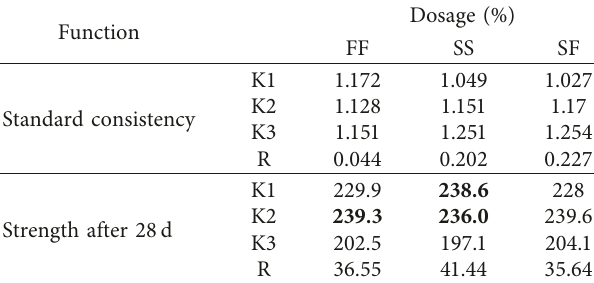
Table 5: Orthogonal test